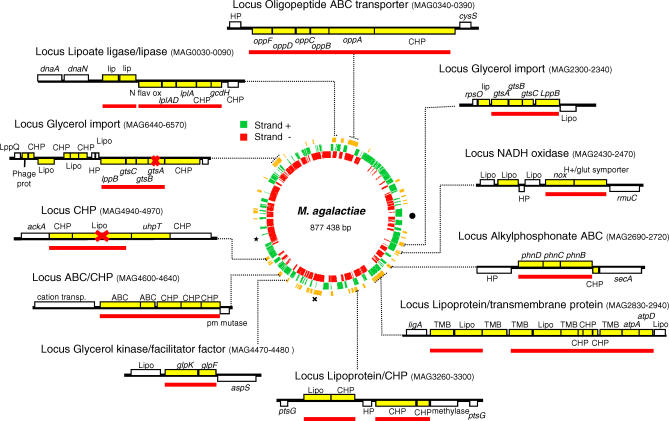
Schematic Presenting the Circular M. agalactiae Genome and the Location of Genes Inherited by Horizontal Transfer from the Mycoides ClusterThe 136 genes potentially inherited from the mycoides cluster are shown on the outer circle as yellow bars, with the inner circles representing the positive (green) or the negative (red) strand. The two adjacent 16S-23S rRNA operons and the two 5S rRNA genes are represented by a star and a dot, respectively. The genomic organization of some transferred genes (yellow boxes above and below the line according to their relative orientation on the genome) is illustrated around the circular map, with pseudogenes indicated by a red cross and tRNAs by black arrowheads. Gene clusters presenting the same organization in M. agalactiae, M. mycoides subsp. mycoides SC, and M. capricolum subsp. capricolum are underlined by red bars. The ICE region, homologous to that of M. capricolum subsp. capricolum but missing in M. mycoides subsp. mycoides SC type strain, is noted by a cross.CHP, conserved hypothetical protein; HP, hypothetical protein; Lipo, predicted lipoprotein; and TMB, predicted transmembrane protein.